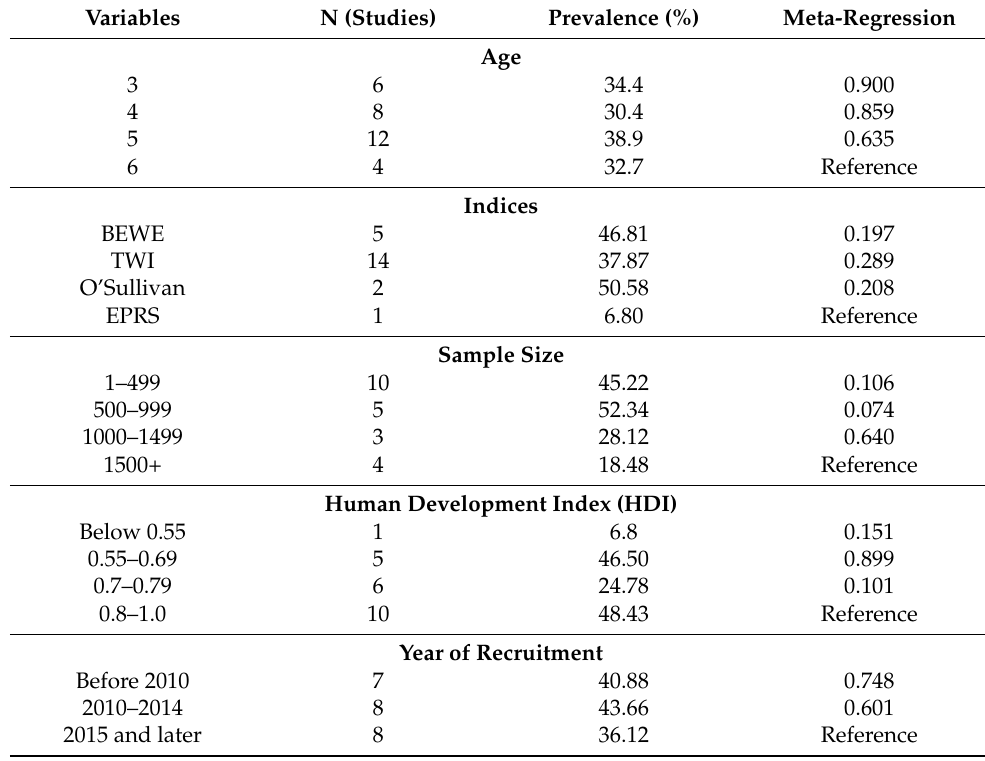
Table 4. Association between factors (age, indices, sample size, HDI, and year of recruitment) and prevalence of erosive tooth